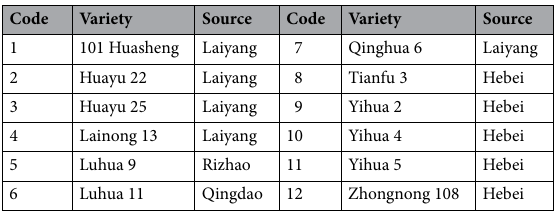
Table 1. Experimental materials for peanut variety